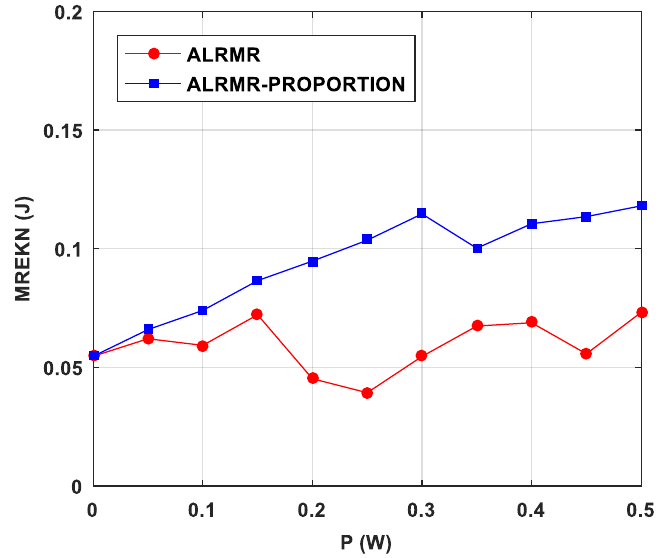
P . Figure 5. Mean residual energy of key nodes (MREKN) with di ff erent values of P .